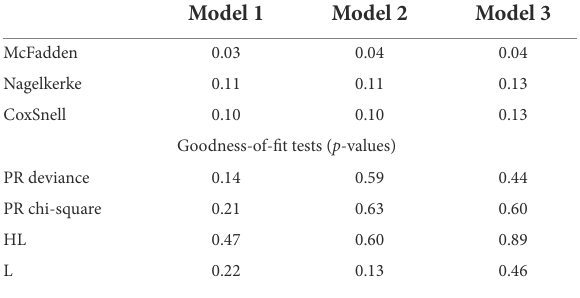
TABLE 5 Goodness-of-fit statistics for each regression model (centered solution, n =